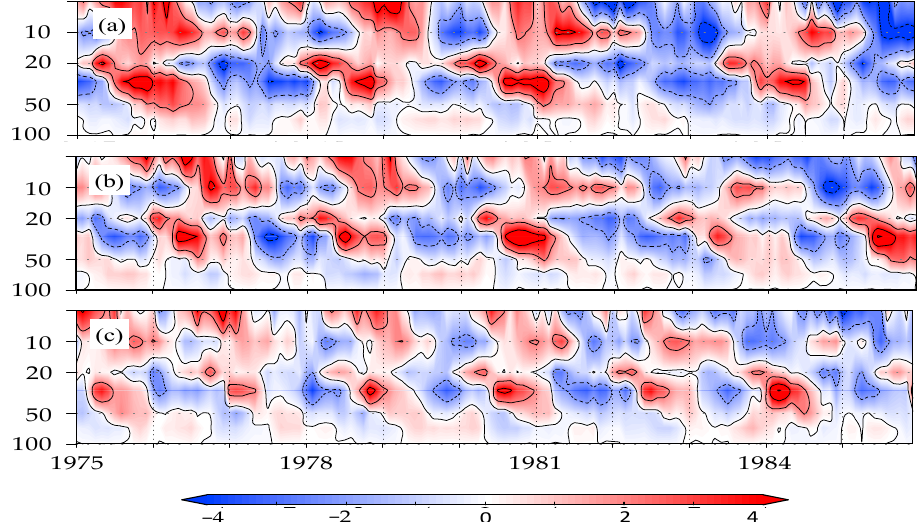
Figure 5. Time–height cross-sections of zonal–mean ozone in the dynamics O 3(dyn) in the tropical stratosphere for the ( a ) P, ( b ) ST, and ( c ) N runs from 1975 to 1985. O 3(dyn) is an anomaly and averaged between 10 ◦ S and 10 ◦ N. Units of the color bar scale are in 0.1 ppmv, and the contours interval is 0.2 ppmv.